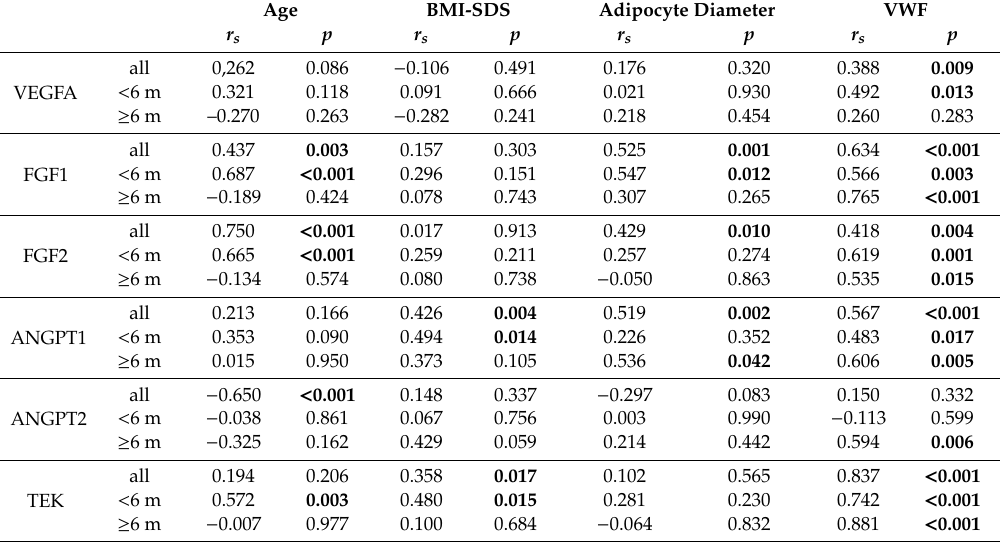
Table 2. Results of the correlation analyses of the angiogenic factors in the Ulm Childhood comparing three age groups.